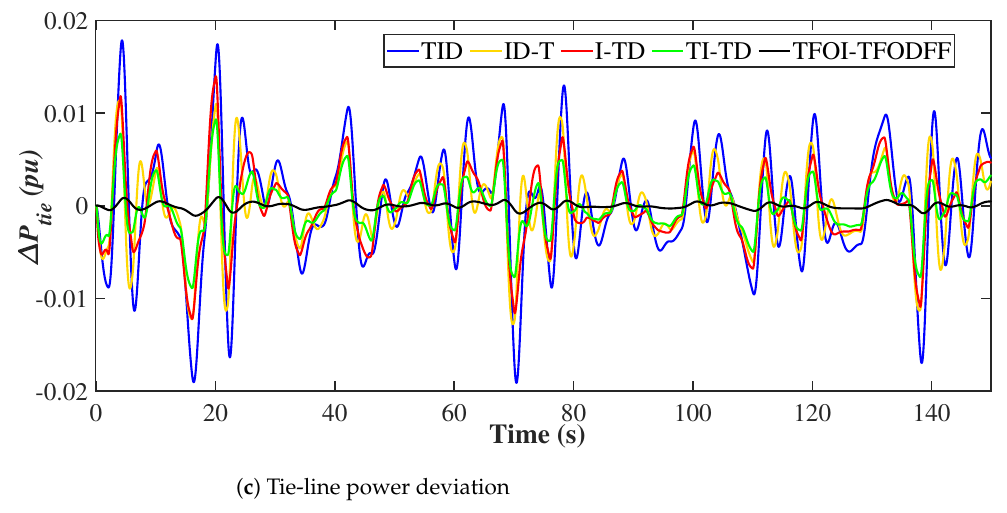
Figure 15. The dynamic response of the system to scenario